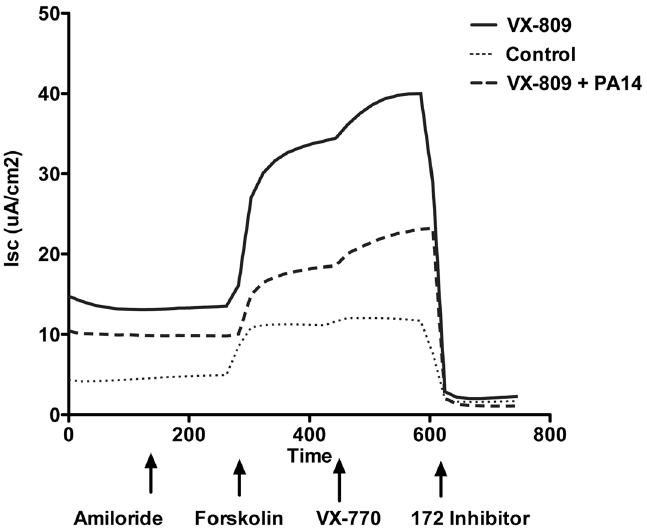
Fig 2. Representative current traces of CFBE cells. Amiloride (50 μ M) was added to the apical bath solution to inhibit the short circuit current ( I sc ) attributed to sodium reabsorption, and subsequently I sc was stimulated with forskolin (FK, 10 μ m), followed by VX-770 (5 μ m), and thiazolidinone (CFTR inh -172, 20 μ m; EMD Millipore, Billerica, MA) to inhibit CFTR-mediated I sc